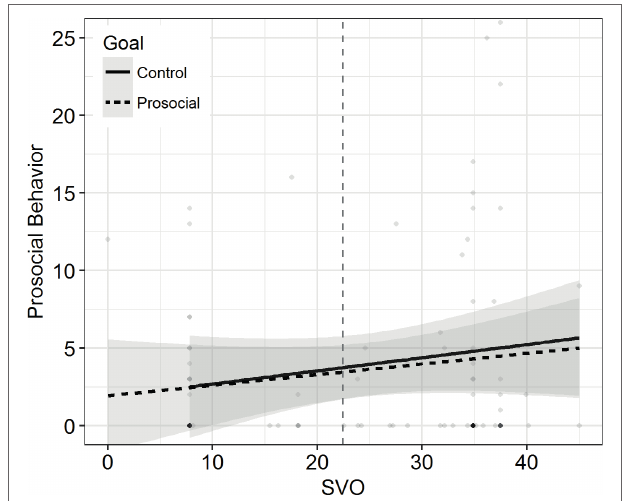
FIGURE 2 | Prosocial Behavior as a function of SVO in Study 1. The separate regression lines represent two conditions. Shades depict 95% CIs. Higher density of the scatter signifies higher concentration of data. Vertical dashed line separates proselfs (left) from prosocials